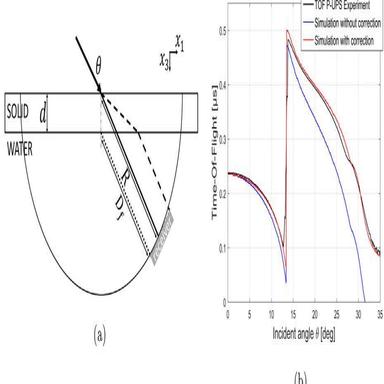
(a) Cross-section of the lower hemisphere (radius R) of the UPS technique along a fixed in plane angle showing the ray path of a wave with incidence angle θ. The dashed and dotted line correspond respectively to the physical path and the path (Df) of the simulated wave. (b) Cross-section of an aluminum TOF P-UPS experiment at a certain in-plane angle ϕ: experimental recording (black), corrected simulation result (red) and uncorrected simulation result (blue).